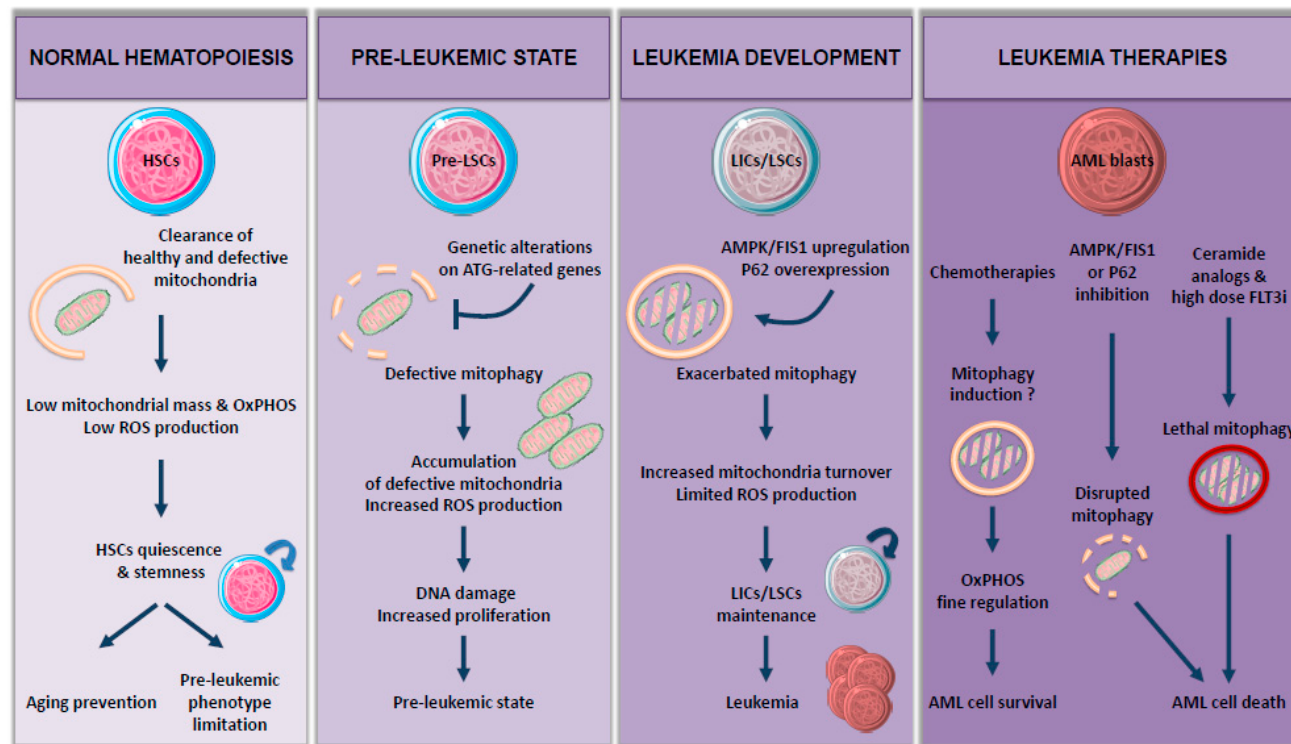
Figure 1. The role of mitophagy: from normal hematopoiesis to leukemia.